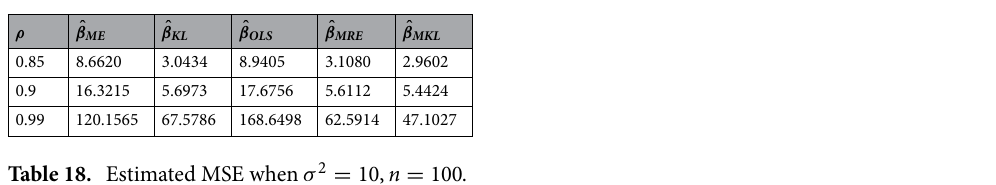
Table 18. Estimated MSE when σ